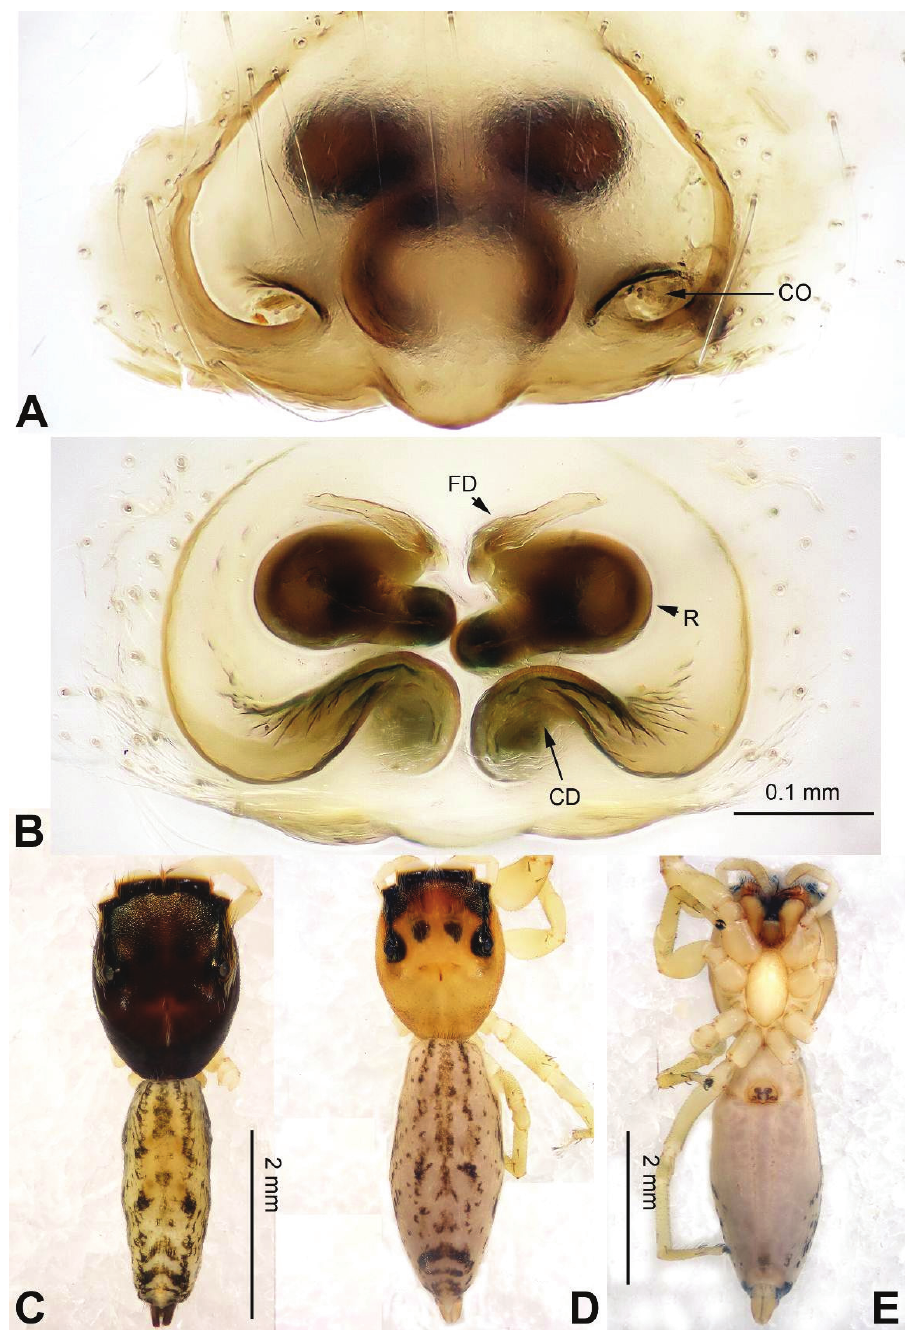
Figure 20. Cosmophasis xiaolonghaensis sp. n., female paratype and male holotype. A epigyne, ventral B vulva, dorsal C male habitus, dorsal D female habitus, dorsal E female habitus, ventral. Scale bars equal for A and B ; equal for D and E